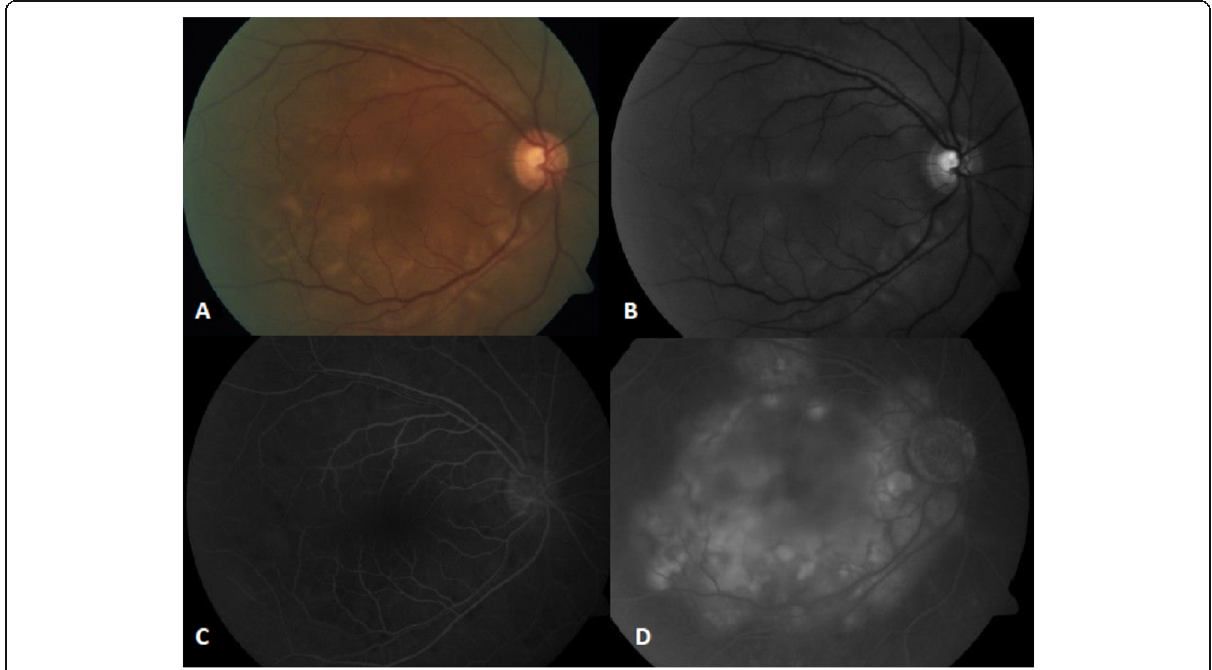
Fig. 1 a Color fundus photograph of the right eye. b The red free of the right eye shows hypopigmented/yellowish areas. c Fluorescein angiogram in the early phase demonstrates patchy hypofluorescence early and d late leakage and pool corresponding to areas of